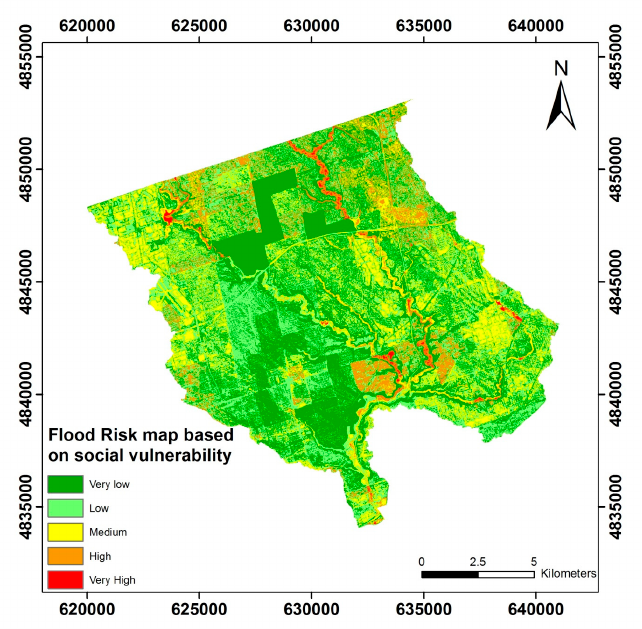
Figure 8. Flood Risk map based on total hazard and total exposure vulnerability.